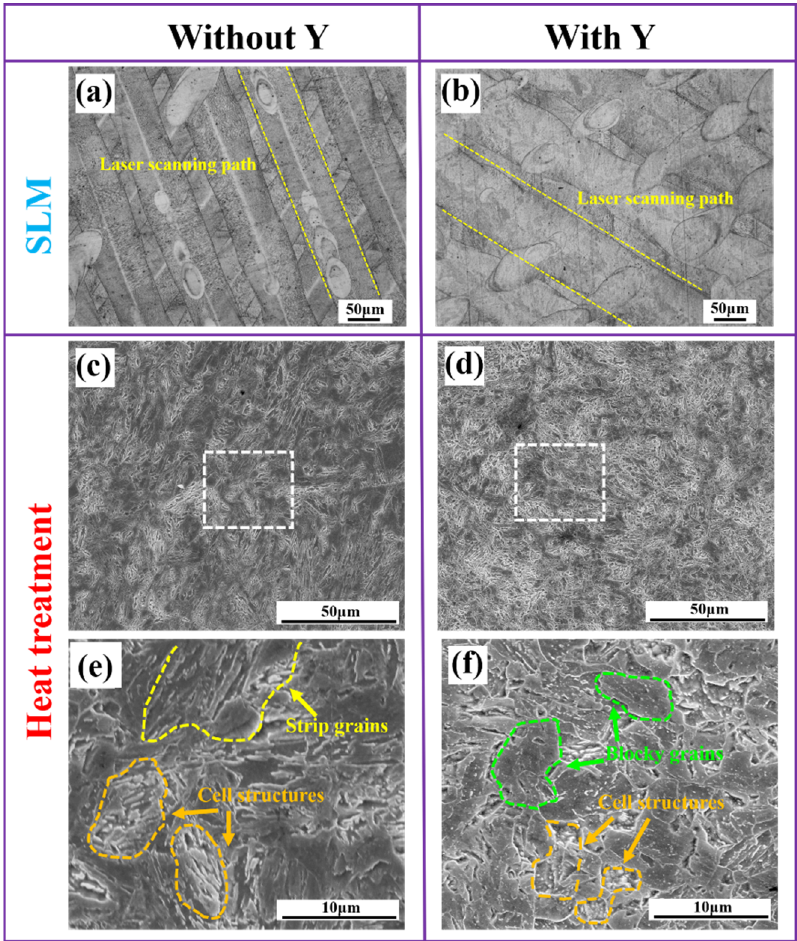
Figure 3. ( a , b ) Microstructure of the as-printed stainless steel parts without and with yttrium, respectively; ( c , d ) microstructure of the stainless steel formed parts without and with yttrium after heat treatment, respectively; ( e , f ) local enlarged areas of ( c , d ), indicated by the white dash rectangle. In order to further observe the effect of yttrium on the grain structure of stainless steel printed parts, EBSD was carried out on the formed parts with Y and without Y after heat treatment, as shown in Figure 4. Through the inversed pole figure (IPF) IPF-z diagram in the X–Y direction (perpendicular to the forming direction), as shown in Figure 4a,d, it was revealed that the grains in the formed parts without yttrium had a certain growth orientation, mainly green, i.e., the <101> direction, indicating that the formed parts had a certain anisotropy. However, the formed parts with yttrium had no specific growth orientation, the grain orientation was dispersed, and the anisotropy was weak. Comparing the grain size distribution (Figure 4b,e), it was found the average grain size of parts without yttrium was 2.02 ± 0.03 mm. The average grain size of parts with yttrium decreased to 0.97 ± 0.02 mm. The EBSD test results further proved that the addition of the rare earth yttrium refined the grain size of the PH13-8Mo stainless steel print. In many studies on rare earth-modified stainless steel, it has been proposed that rare earth elements can refine the grain size, which is also a reason why the addition of rare earth can improve the strength of stainless steel [17–19]. By comparing the angular distribution of grain boundaries (Figure 4c,f), it was found that there were more low-angle grain boundaries (5 ◦ ~10 ◦ ) in the formed parts with yttrium. This also showed that the addition of yttrium played a role in refining the grains of the formed